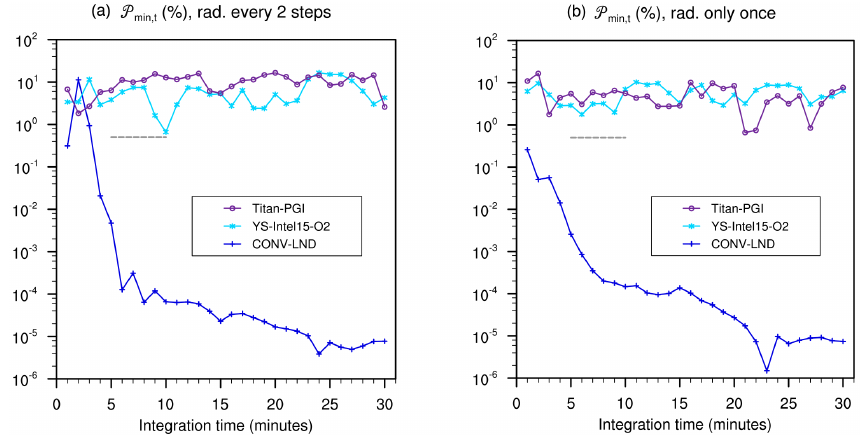
Figure 6. As in Fig. 4b, but showing only a few test scenarios to compare the results obtained from simulations where (a) radiation is calculated every other time step, and (b) radiation is calculated only at the beginning of the